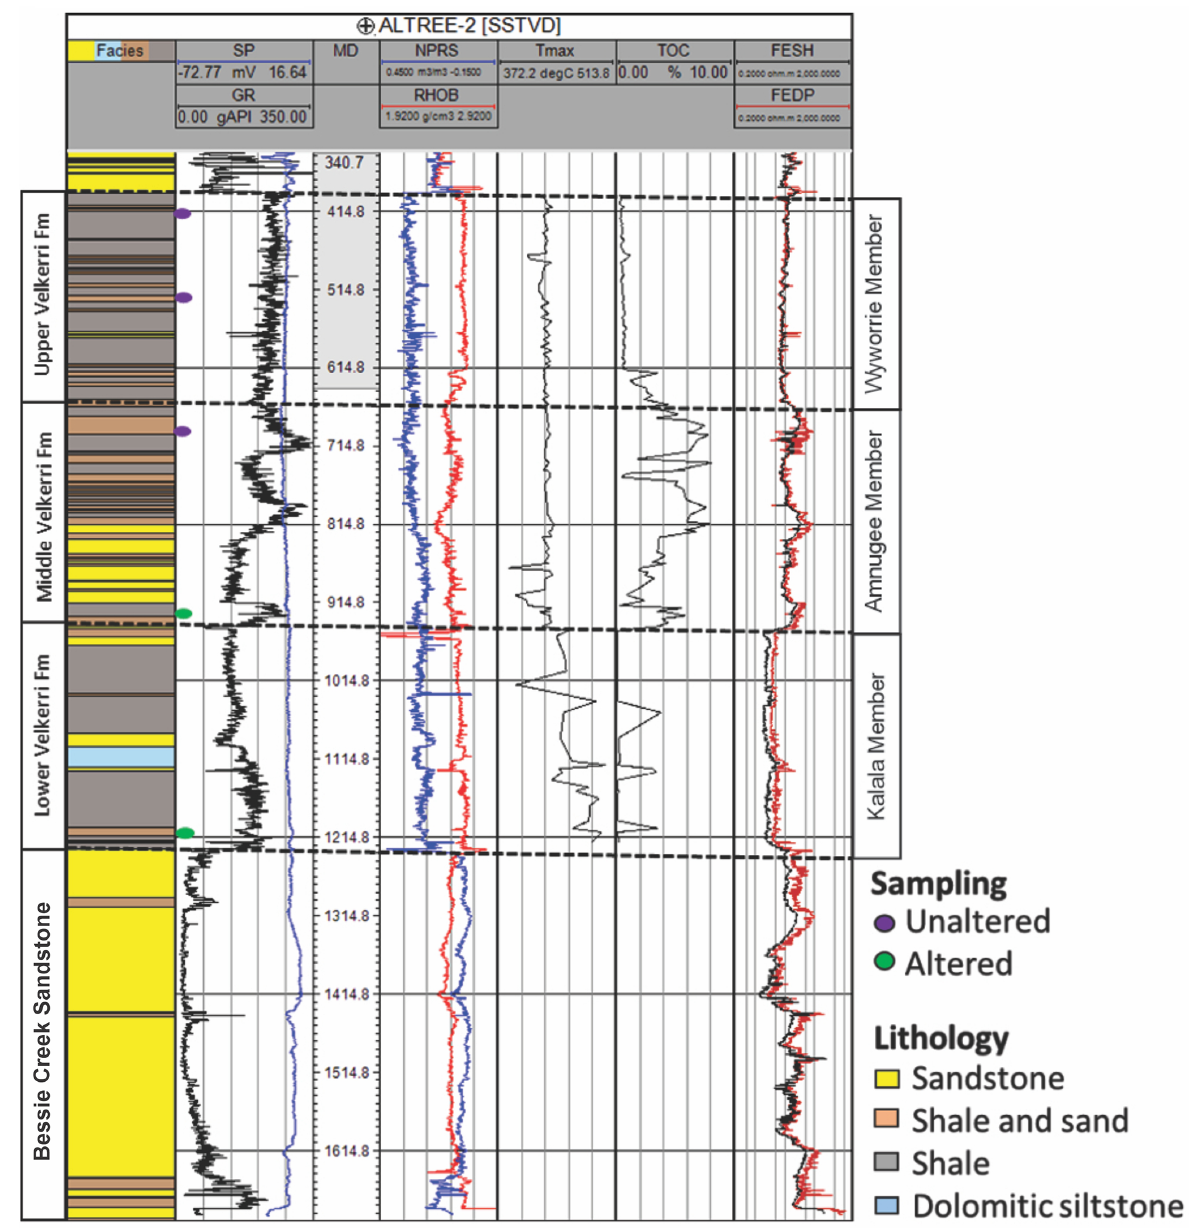
Figure 2. Summary of reprocessed downhole well log data for Altree